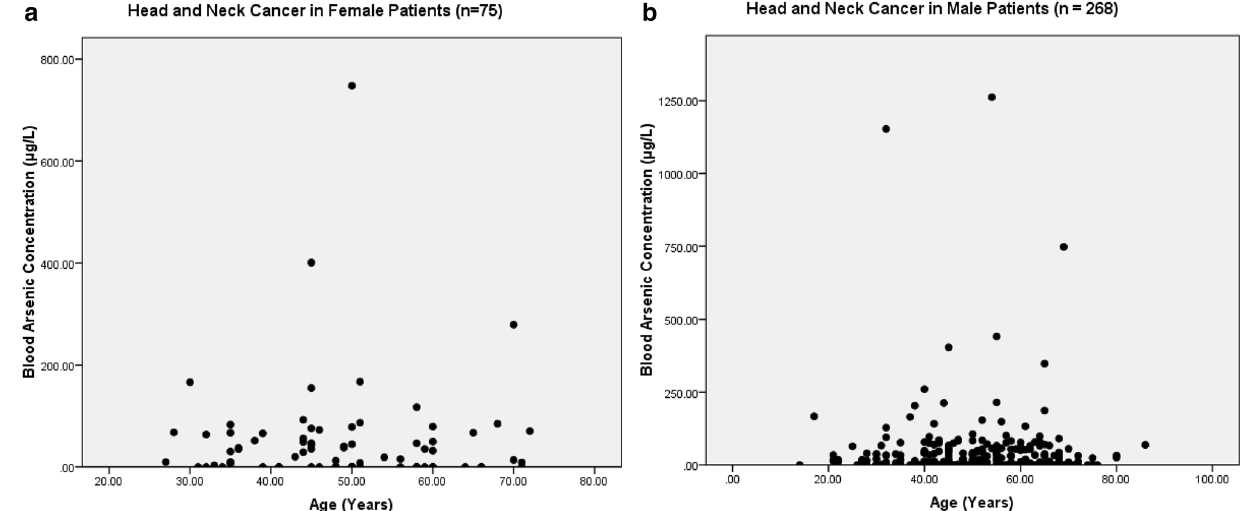
Figure 14. The correlation coefficient between blood arsenic levels and age of the female vs male head and neck cancer patients (P < 0.05).